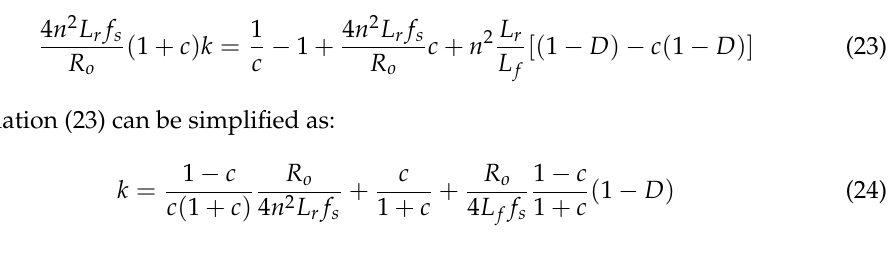
Figure 7. Solutions of k for different values of c at different output resistances. 3.3. Designs of a Dynamic Hybrid Compensator for Current Sharing Control of Parallel PSFB From the above analysis, the impact on the current sharing error on filter inductor difference is minimal, and the ratio difference is the major influencing factor. Define phase #1 as the master module, and phase#2 as the slave module. Introducing a phase shift duty cycle compensation, d , the relationship between the master module phase shift duty cycle